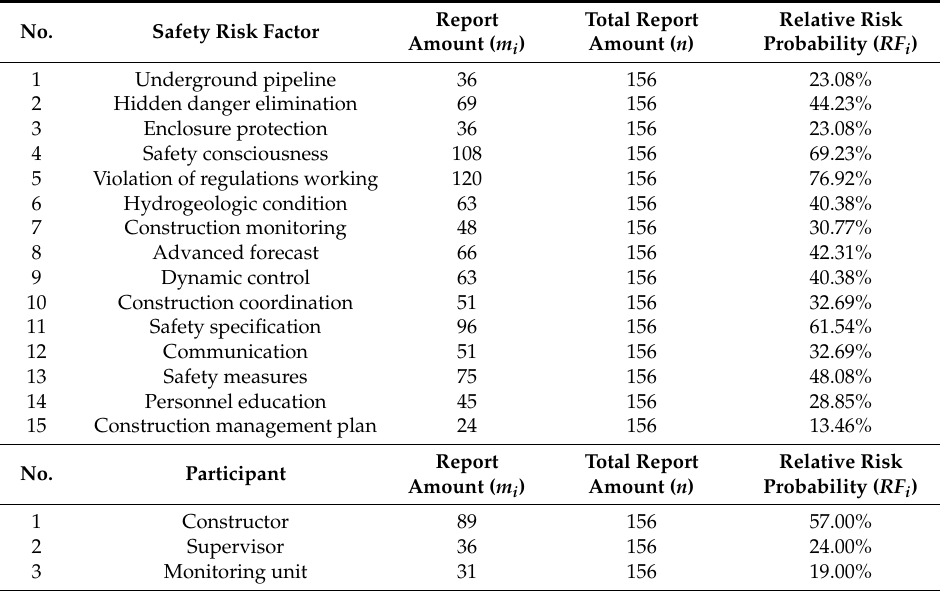
Table4. Safety risk factors and relative risk probability. Table 4. Safety risk factors and relative risk probability.